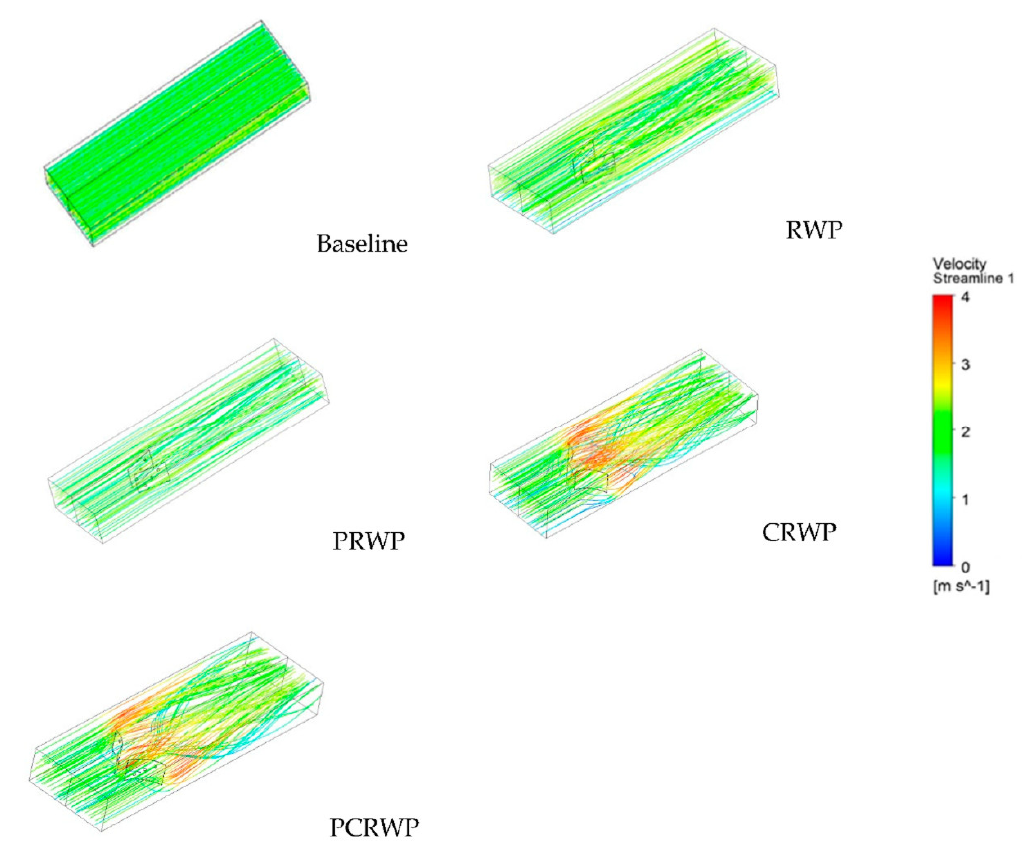
Figure 6. Streamline velocity of flow with/without VG.